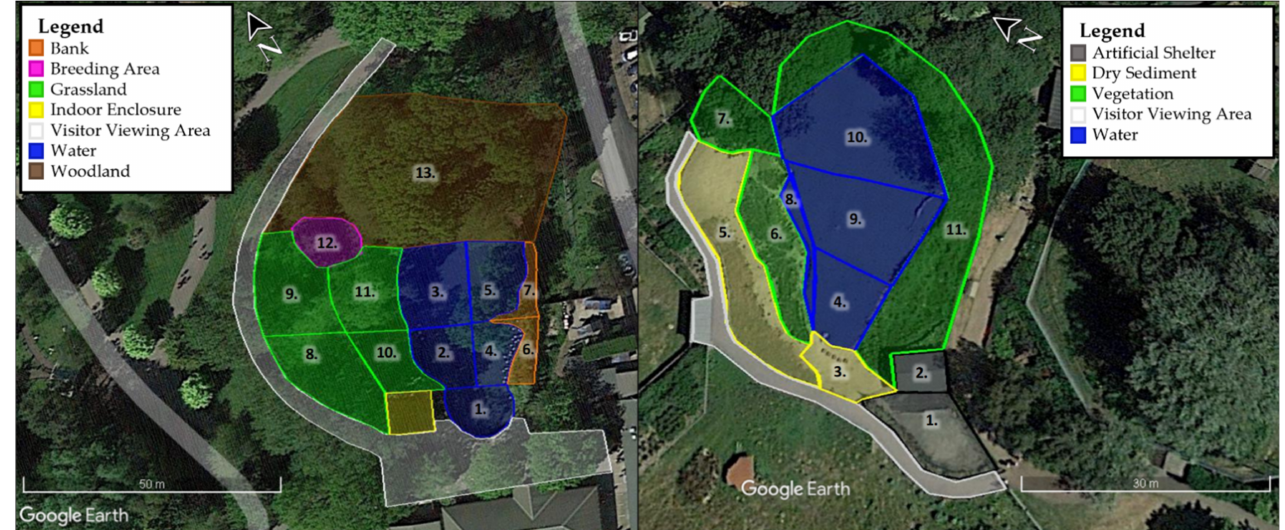
Figure 1. Map data ©2021 Google Earth Pro. Left: Greater Flamingo enclosure at Africa Alive. 1 = Overlooked; 2 = Front Left Water (FLW); 3 = Back Left Water (BLW); 4 = Front Right Water (FRW); 5 = Back Right Water (BRW); 6 = Front High Bank (FHB); 7 = Back Low Bank (BLB); 8 = Back Grassland Path (BGP); 9 = Front Grassland Path (FGP); 10 = Front Grassland Water (FGW); 11 = Back Grassland Water (BGW); 12 = Nesting Zone (NZ); 13 = Woodland. Right: Chilean Flamingo enclosure at Banham Zoo. 1 = Yard; 2 = Shelter; 3 = Beach; 4 = Front Shallow Water (FSW); 5 = Hill; 6 = Slope; 7 = Canopy Cover (CC); 8 = Left Shallow Water (LSW); 9 = Middle Deep Water (MDW); 10 = Far Deep Water (FDW); 11 = Overgrown Bank